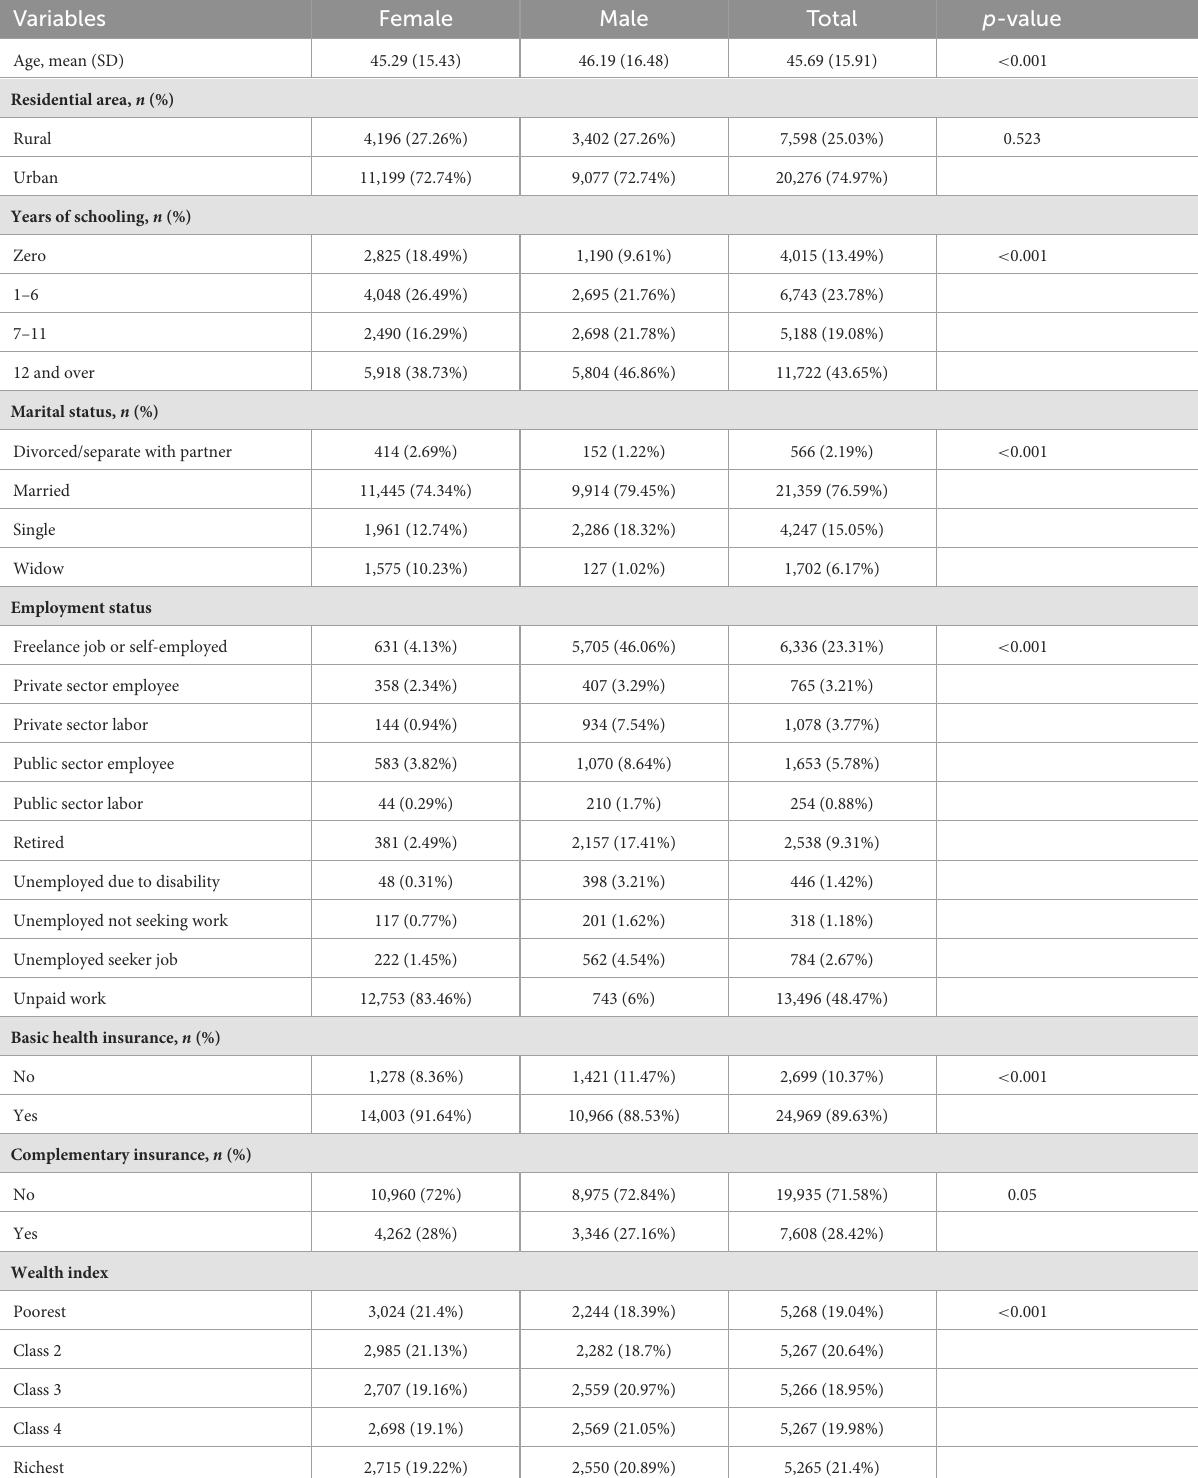
TABLE 1 Baseline characteristics of